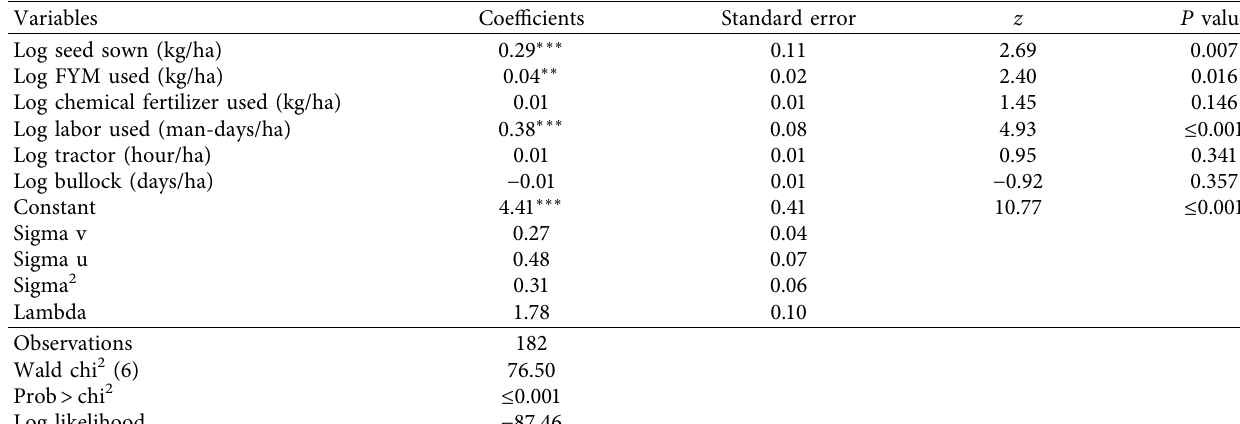
Table 3: Stochastic frontier production of maize seed production.